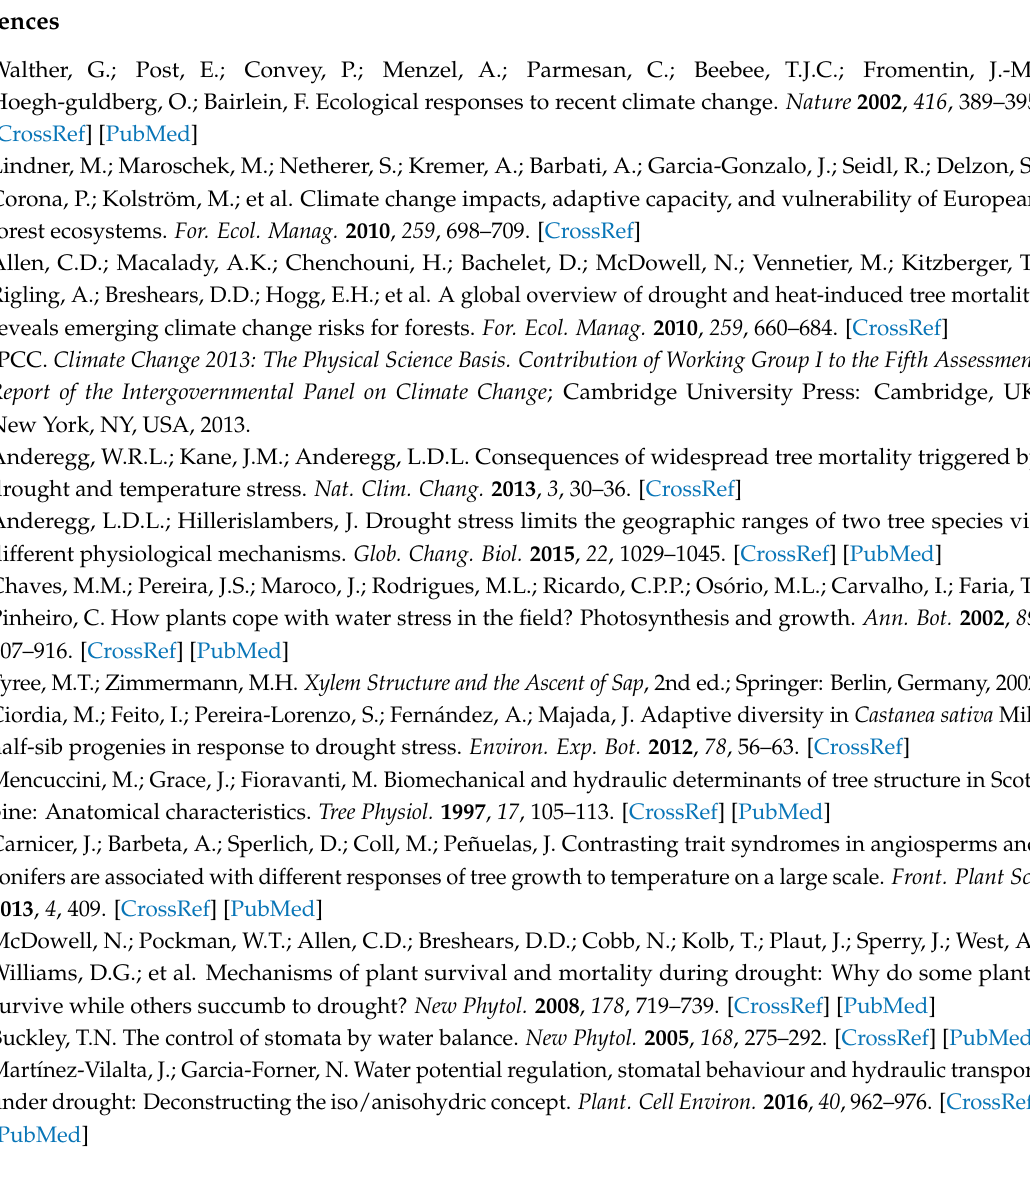
Figure S1: Climatic treatments and density arrangement and dimensions, Figure S2. Difference in maximum, mean and minimum temperatures between the control and each treatment for the years 2014 and 2015, Table S1: Dimensions of the 3-year old internode segments as mean value ± standard deviation ( n = 12) per treatment, Table S2. Influence of the density of plantation in the studied